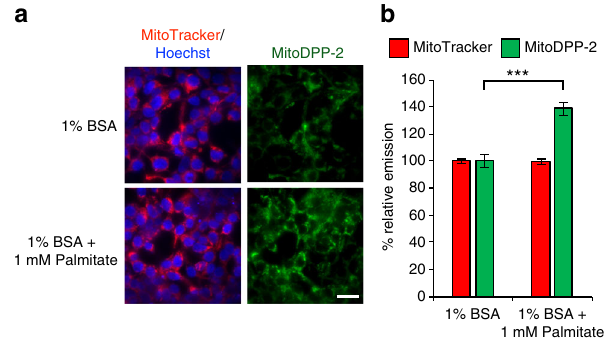
Fig. 8 Palmitate activates mitochondrial S -deacylase activity. a HEK293T cells were treated for 6 h with 1% BSA ± 1 mM palmitate post- starvation (6 h), followed by treatment with 1 µ M Hoechst 33342, 100 nM MitoTracker Deep Red for 30 min, washed, loaded with 500 nM mitoDPP-2 for 10 min, and then analyzed by fl uorescence microscopy. 20 µ m scale bar shown. b Quanti fi cation of the relative fl uorescence intensity from mitoDPP-2 and MitoTracker in 1% BSA ± 1 mM palmitate-treated cells from ( a ). Statistical analyses performed with a two-tailed Student ′ s t -test with unequal variance, ** P value < 0.0005, n = 6 for ( b ), error bars are ± s.e.m